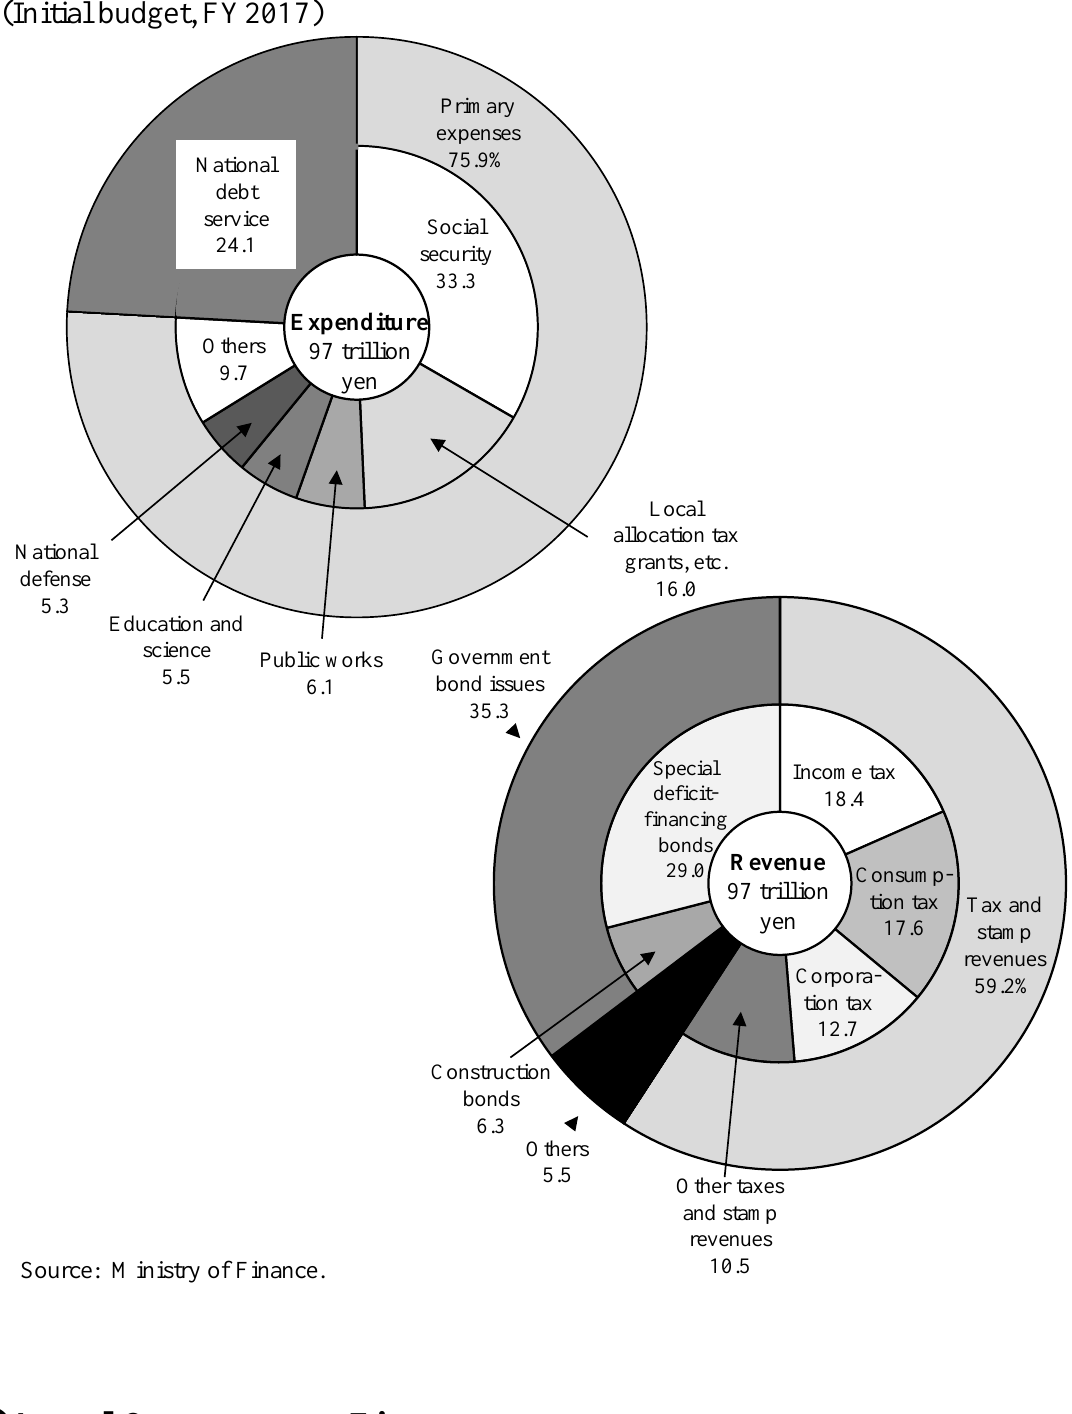
Source: Ministry of Finance.